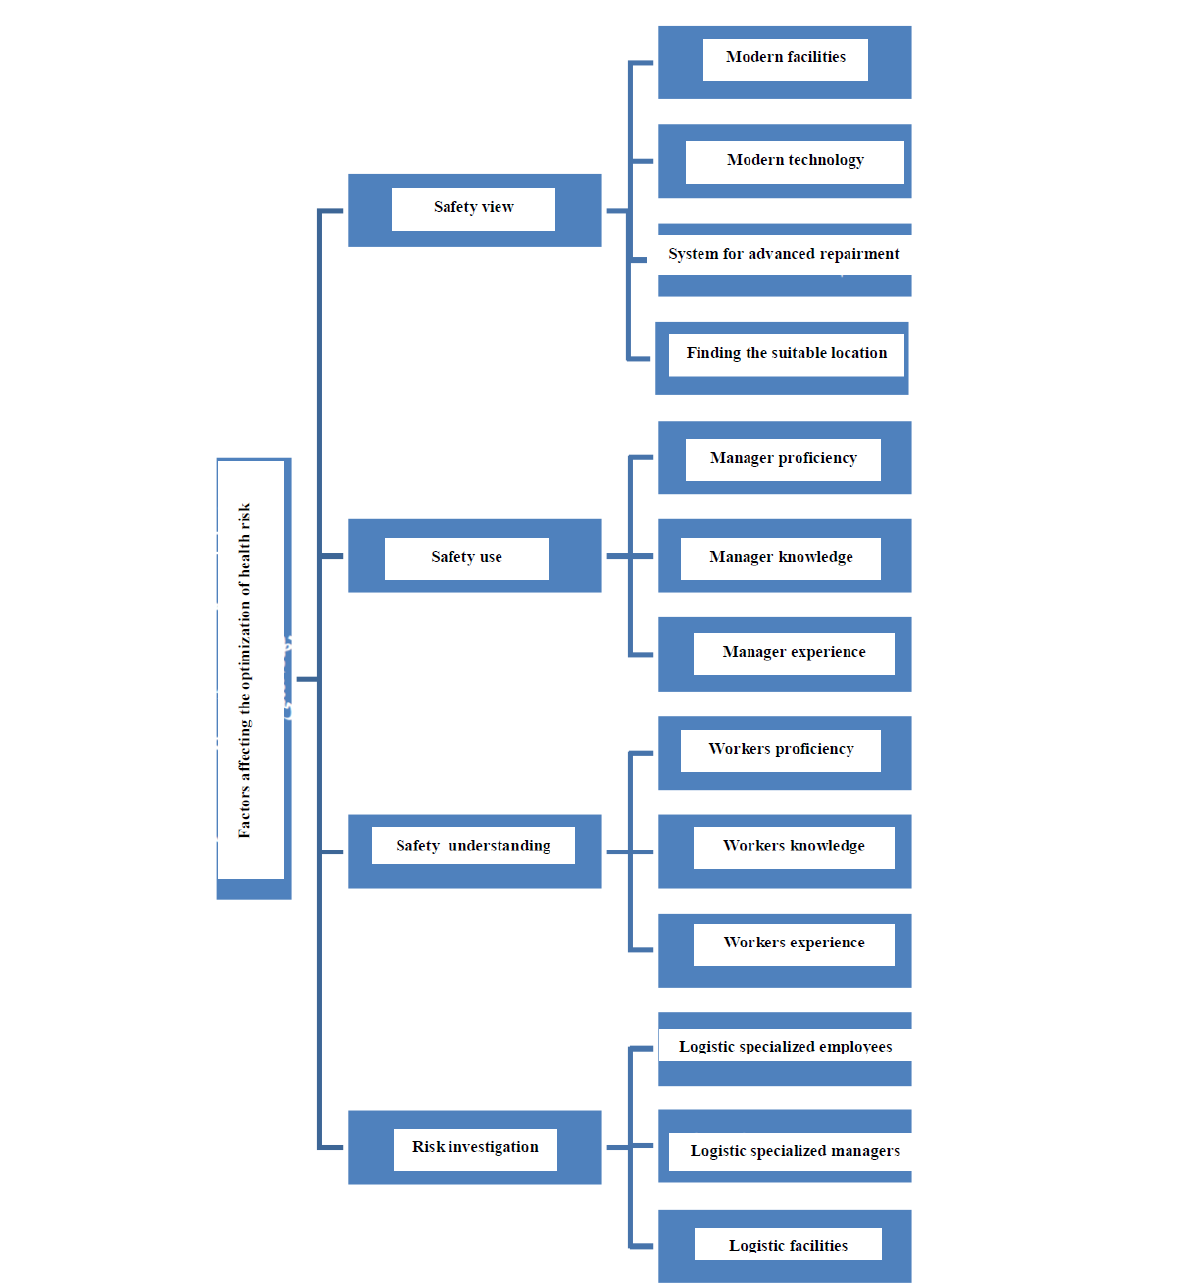
Figure 2. Network model to determine the optimization factors of the health risk